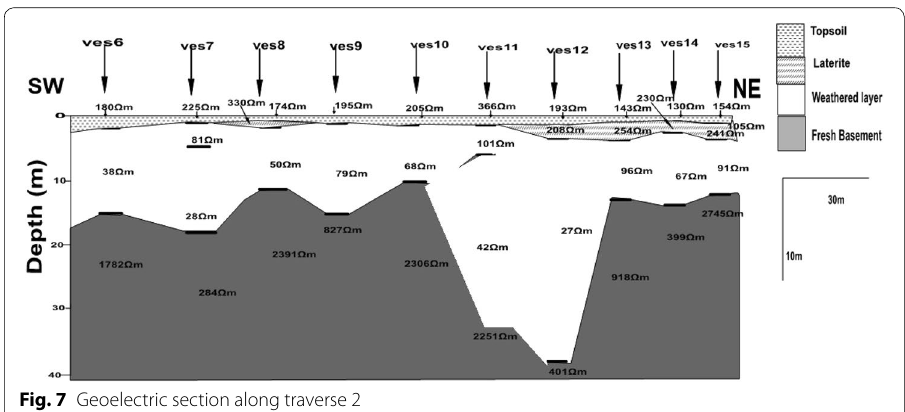
Fig. 7 Geoelectric section along traverse